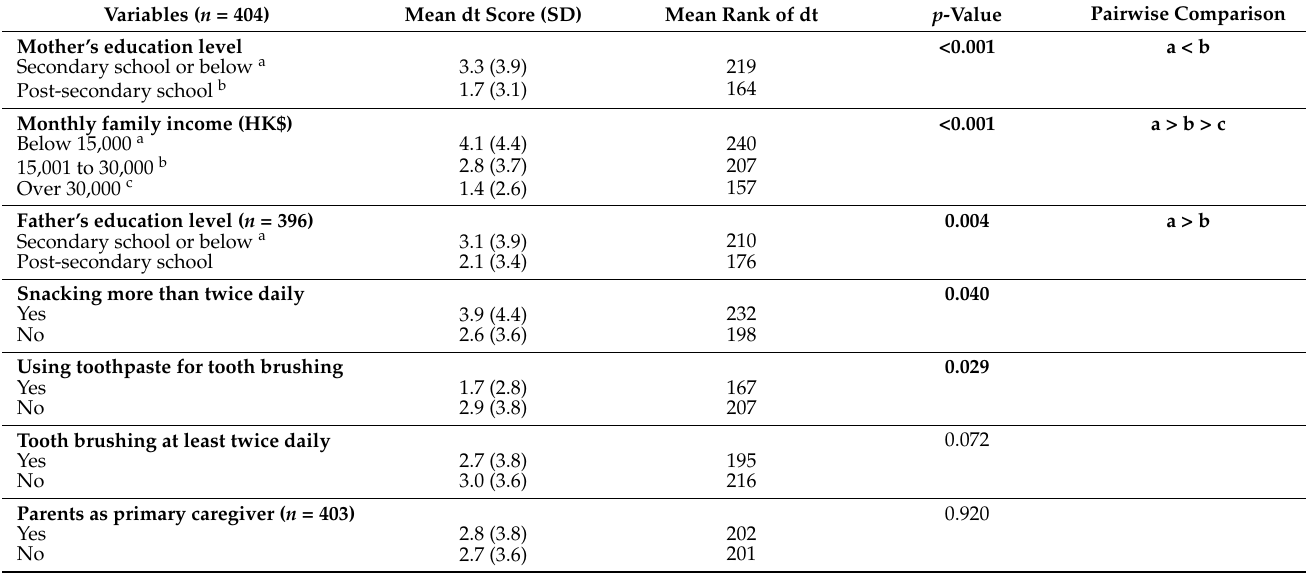
Table 3. Untreated ECC (dt) and independent variables.